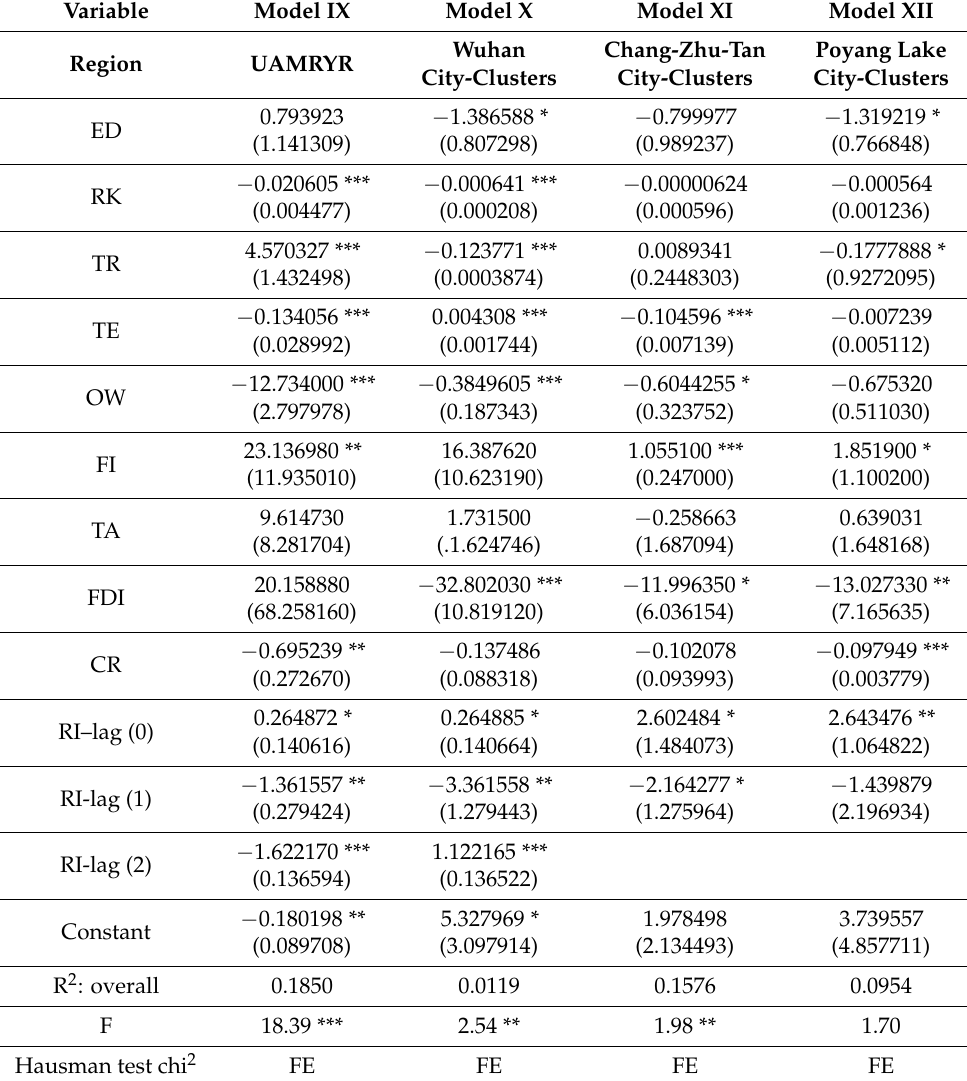
Table 5. The results of threshold regression with RI-lag as threshold